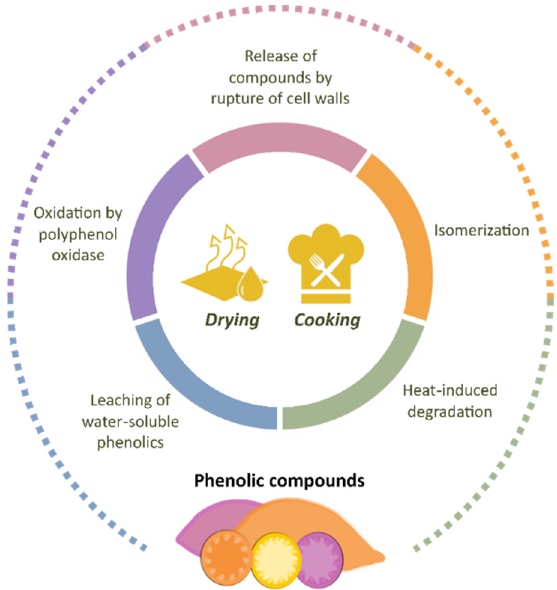
Figure 7. Main factors affecting the phenolic profile in sweet potato during processing.